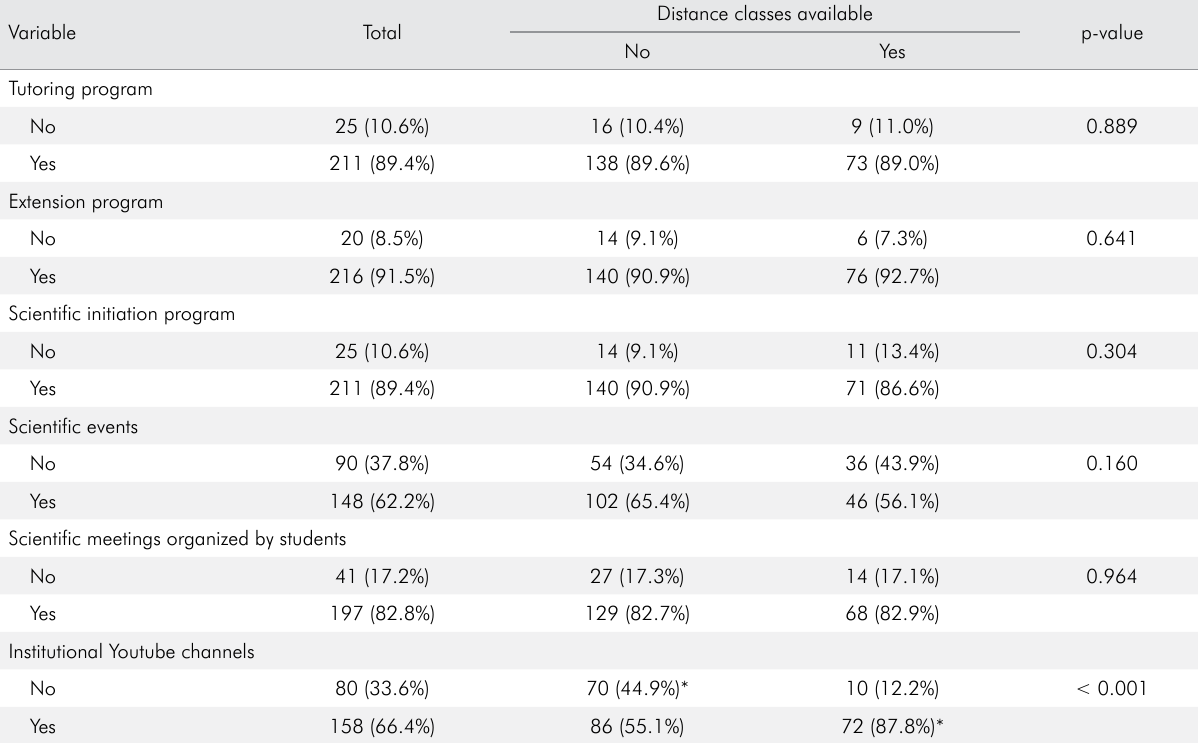
Table 4. Profile of the extracurricular activities and programs and presence of Youtube channels in regulated dentistry courses with and without distance classes in